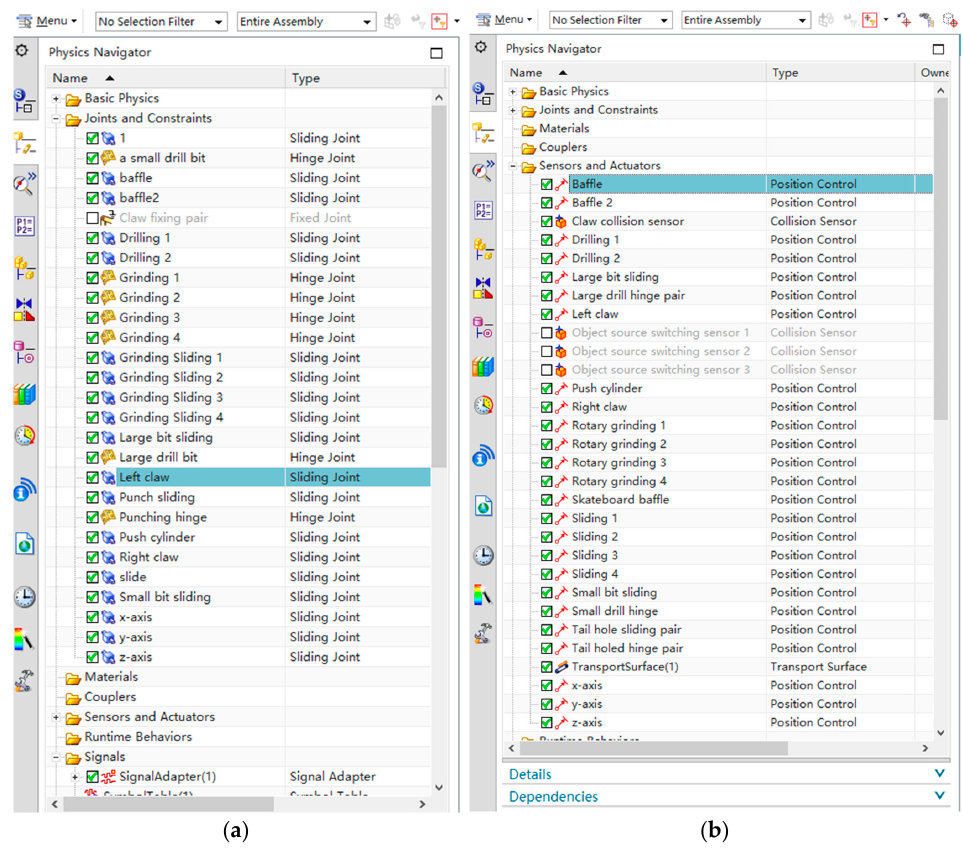
Figure 7. ( a ) The settings of kinematic pairs; ( b ) The settings of sensors and actuators.